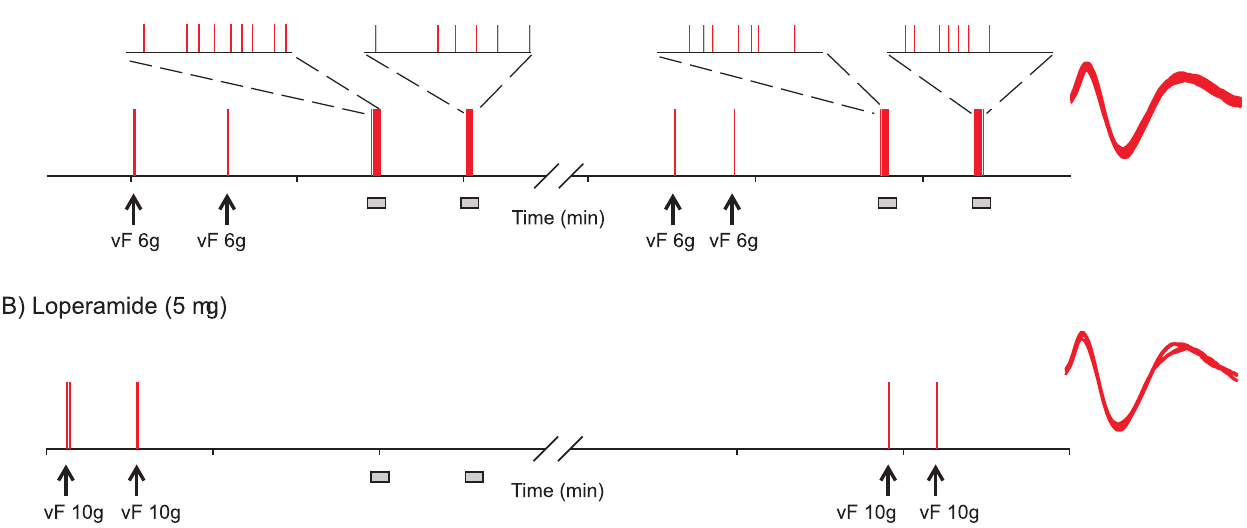
Figure 1. Specimen recording showing the effect of loperamide on the mechanosensitivity of an unmyelinated afferent (AE49.02C) recorded from a spinal nerve lesioned animal 9 days post injury. Vertical bars indicate occurrence of an action potential (AP). Arrows indicate von Frey hair application to determine mechanical threshold. Grey bars indicate tonic suprathreshold stimulation (5 s) with an 8 g von Frey hair. A) Responses to mechanical tests at baseline. In the two test sequences for baseline testing, the afferent responded to 2/2 trials of stimulation with a 6 g von Frey hair (but not to the next lower 4 gm von Frey hair, data not shown), and suprathreshold stimulation with 8 g von Frey hair induced a total of 15 and 14 action potentials in the first and second test sequence, respectively. Insets show occurrence of action potential recorded during suprathreshold stimulation at higher time resolution. On the right, all AP waveforms recorded during baseline testing are shown superimposed. B) Mechanical responses after injection of a cumulative 5 m g dose of loperamide (1.25 m g followed by 3.75 m g). The von Frey threshold increased to 10 g, and the afferent became unresponsive to tonic stimulation with 8 g. In the second test sequence, mechanical von Frey threshold was still 10 g. Responses to 8 g von Frey hair stimulation were not tested.